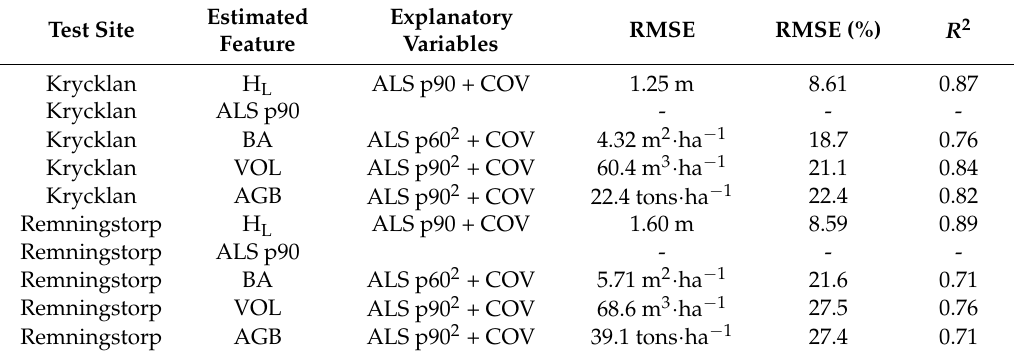
Table 8. Results estimated solely from ALS metrics. COV describes the ALS canopy cover. The other abbreviations have the same meaning as